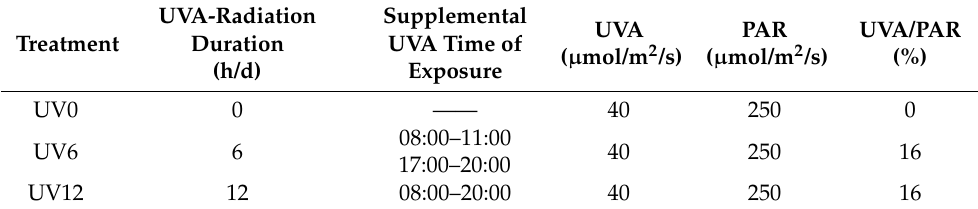
Table 1. The lighting characteristics of the three light